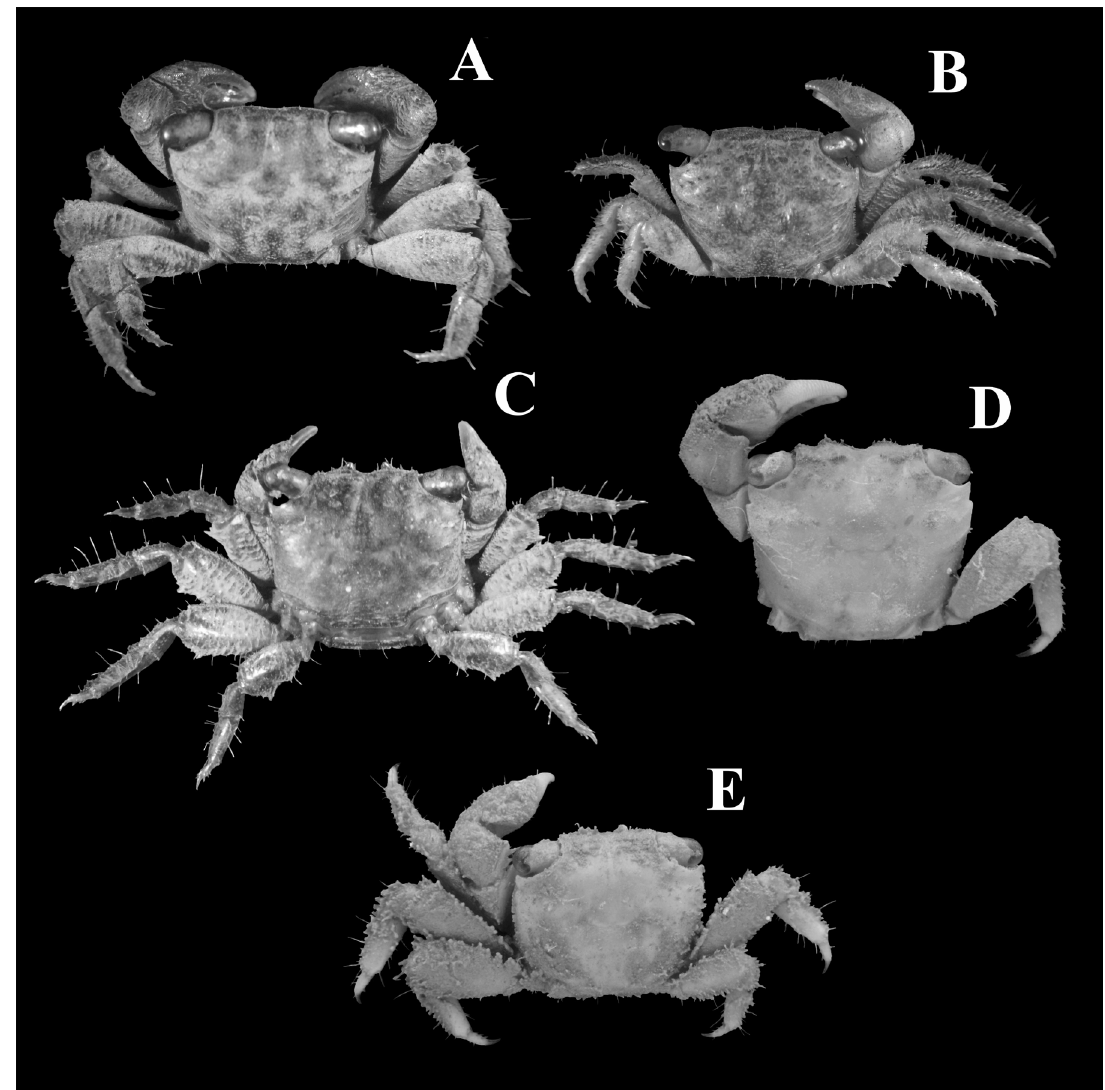
Figure 1. Dorsal habitus of Nanosesarma species. ( A ) N. andersoni (De Man, 1888), male (LFSC.ZRC-185) CL: 6.2 mm; CW: 8.4 mm; ( B ) N. batavicum (Moreira, 1903), male (GUMSIS1), CL: 4.8 mm; CW: 6.6 mm; ( C ) N. minutum (de Man, 1887), male (LFSC.ZRC-186), CL: 4.8 mm; CW: 5.9 mm; ( D ) N. sarii Naderloo and Türkay, 2009, male (LFSC.ZRC-188), CL: 5.6 mm; CW: 6.6 mm; ( E ) N. jousseaumei (Nobili, 1906), male (LFSC.ZRC-187), CL: 4.8 mm; CW: 5.5